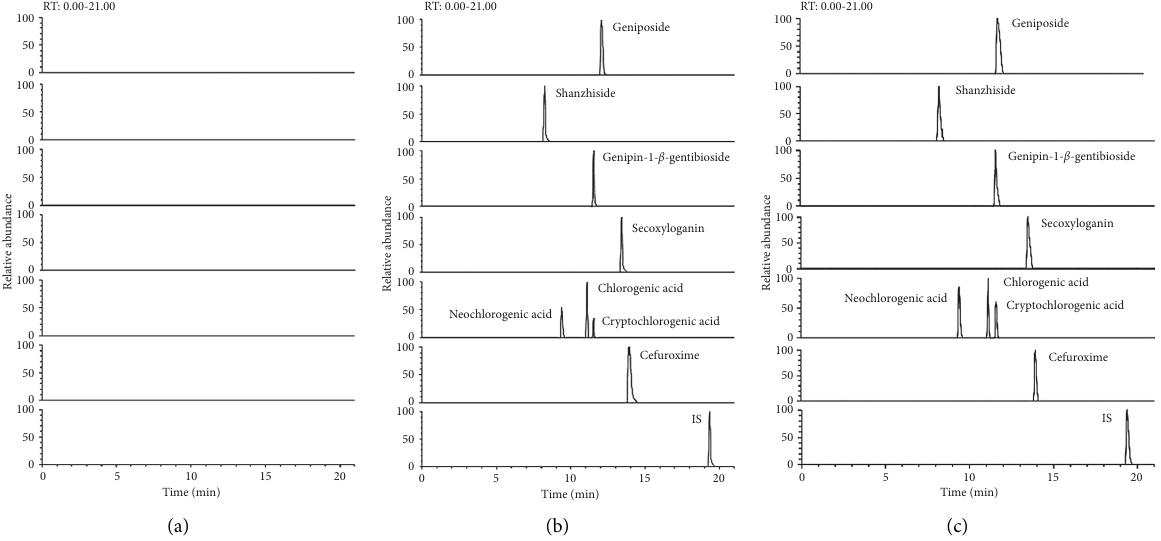
Figure 3: The representative ion chromatograms of seven analytes, cefuroxime, and clarithromycin (IS): (a) blank plasma, (b) blank plasma spiked with seven analytes, cefuroxime, and IS, and (c) medicated plasma sample.